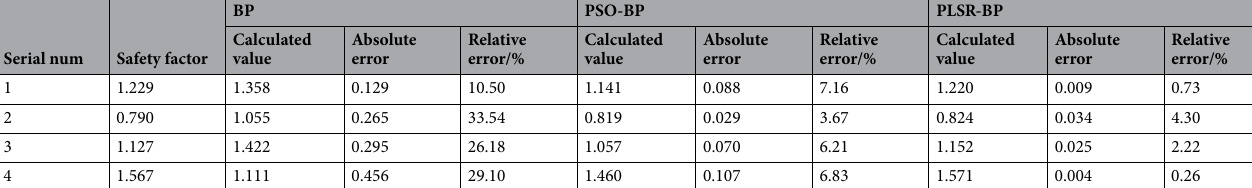
Table 5. Comparison between network outputs and practical